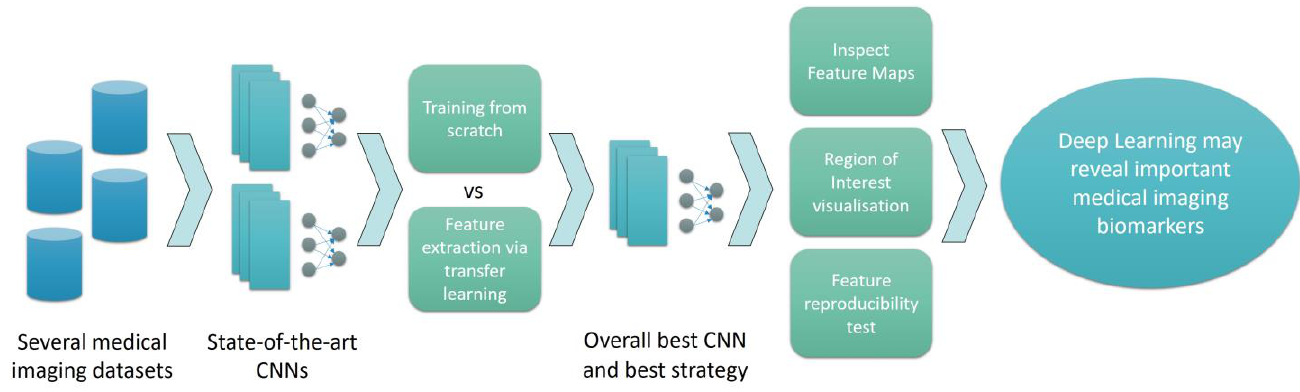
Figure 2. Methodology of the current research work.